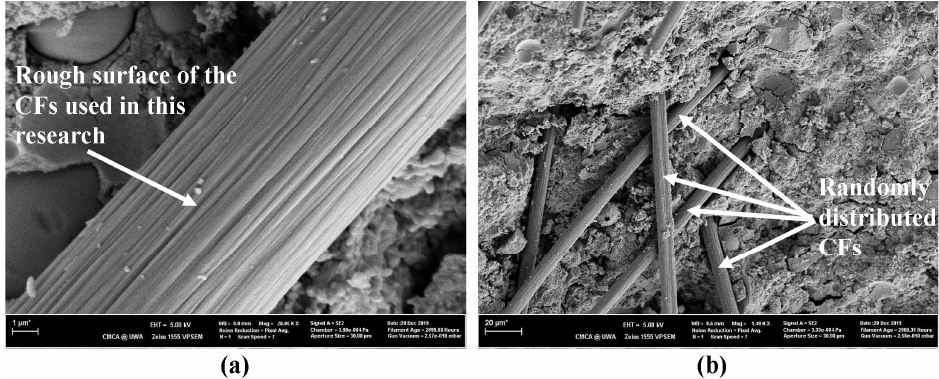
Figure 9. ( a ) Close up of CF used in the research; ( b ) distribution of CF in the geopolymer matrix.